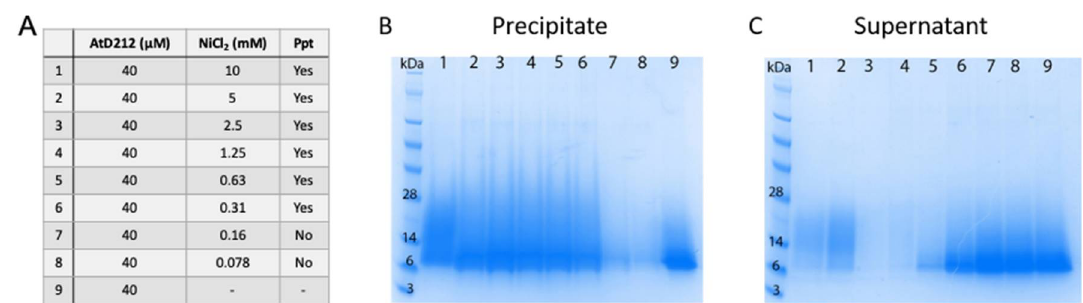
Figure 2. NiCl 2 induced precipitation of AtD212. ( A ) AtD212 was mixed with a range of concentrations of NiCl 2 and assessed for precipitation by the eye. Precipitate formed at NiCl 2 concentrations of 0.31 mM and above. The samples were centrifuged and the precipitate ( B ) and supernatant ( C ) were analyzed by SDS-PAGE. The majority of HRD protein was in the precipitate. At concentrations where there was no precipitation the majority of HRD was in the supernatant. Lane 9 on both gels is 40 µ M AtD90 run as a control.